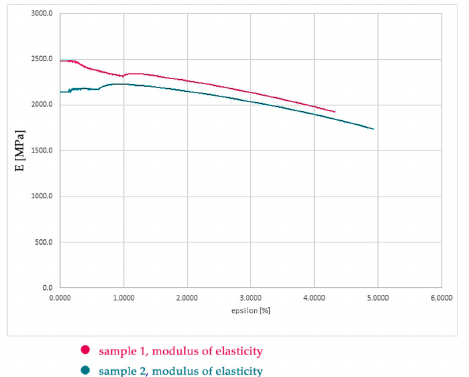
Figure 10. Modulus of elasticity of the sample 1 (red) and sample 2 (aquamarine) depending on the relative